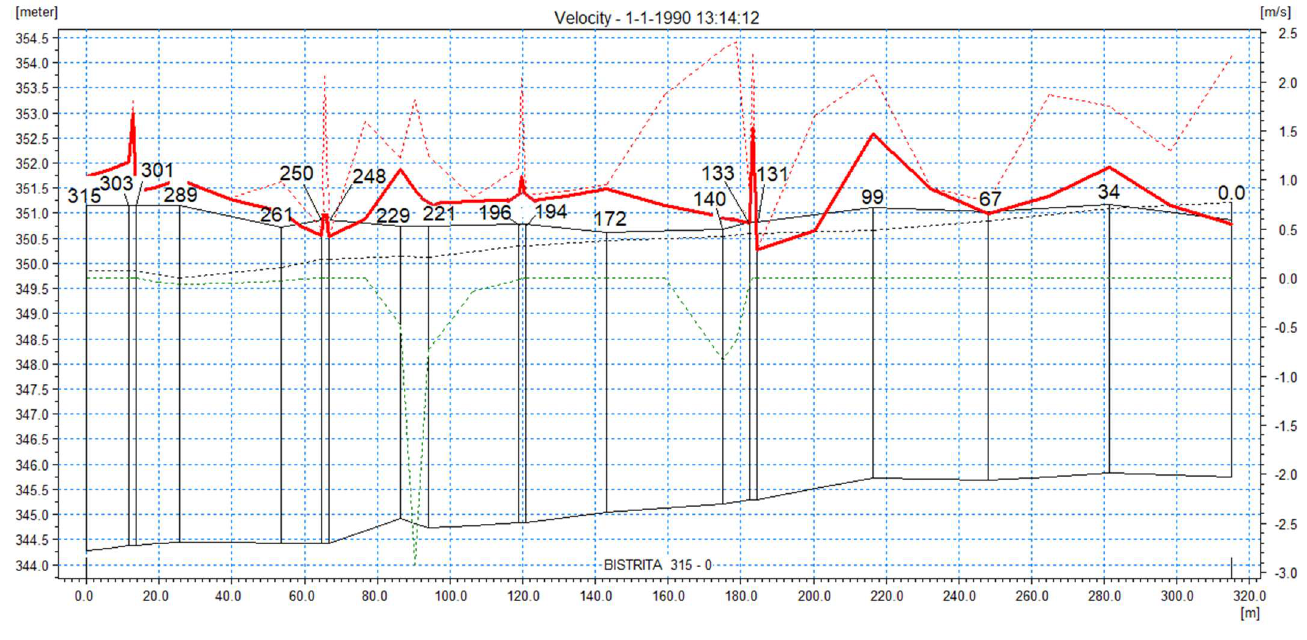
Figure 13. Water speed for flow Q = 3.56 m 3 /s, summer flow recorded in June 2022. For the proposed case with the lowering of the crest of the existing weir and the construction of three new weirs of low height downstream of it.